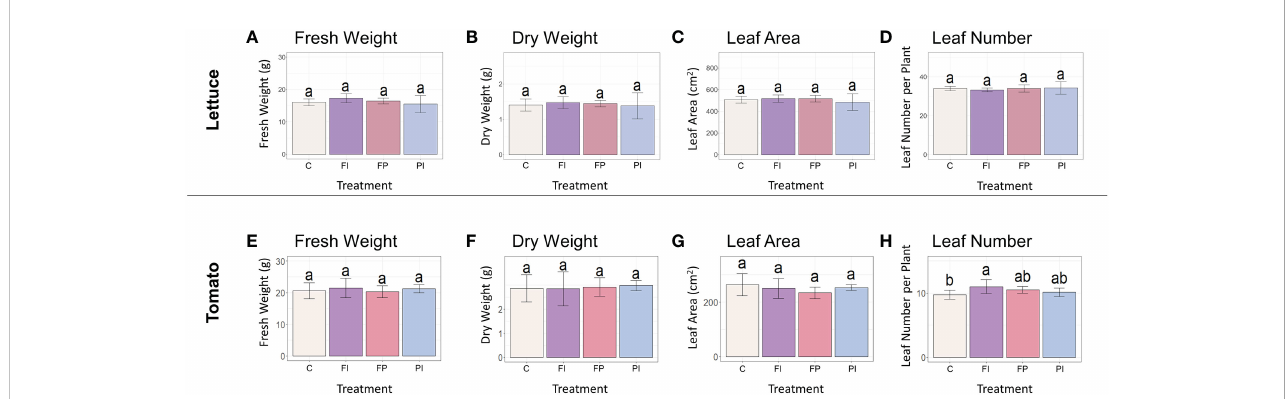
FIGURE 2 Biomass accumulation of lettuce and tomato under OSC fi lters. (A) Lettuce fresh weight of lettuce grown under OSC fi lters and clear glass control (C) . (B) Lettuce dry weight grown under OSC fi lters. (C) Lettuce leaf area under OSC fi lters. (D) Number of leaves per lettuce plant under OSC fi lters. (E – H)